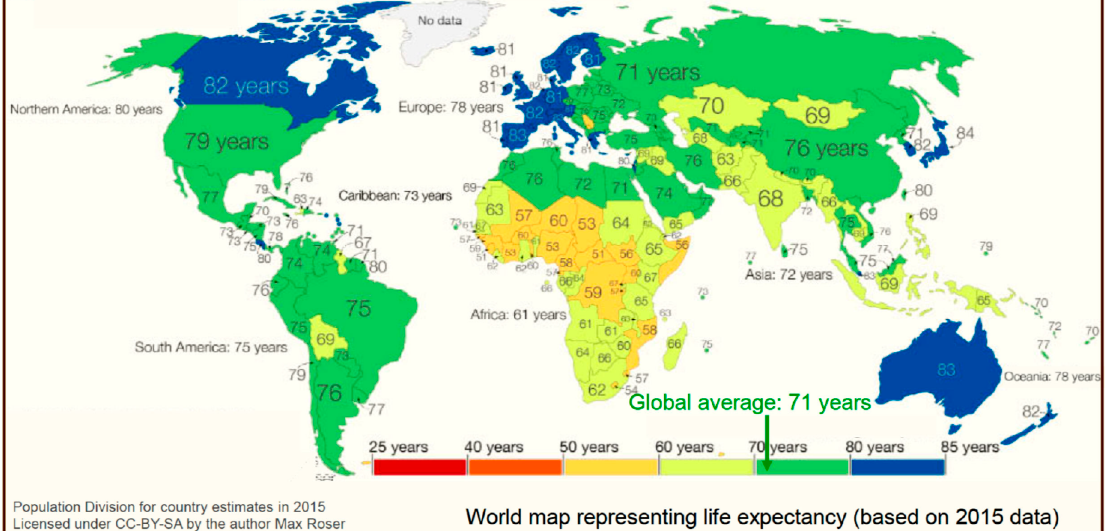
Figure 4. Geographical distribution of a long and healthy life index: life expectancy at birth.